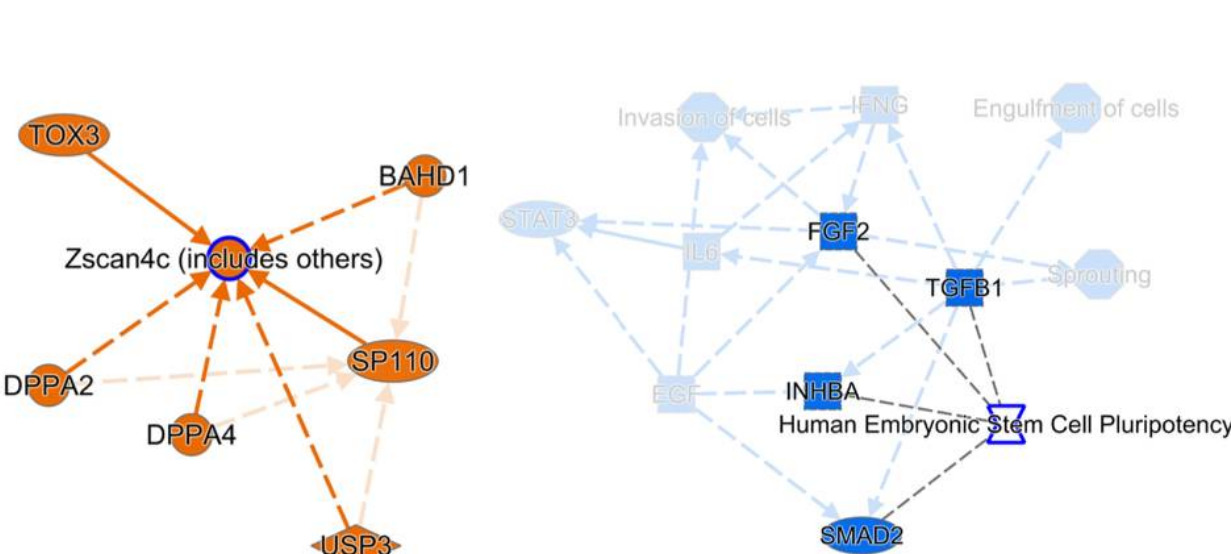
Figure 5. Differential gene and pathway analyses of TBLCs and mid-late 2-cells. ( A ) Heatmaps showing average differential gene expression patterns of mid-late 2-cells (top) and TBLCs (bottom) gene markers. Scale bar indicates z-scored gene expression value. ( B ) The top 5 canonical pathways were derived from ingenuity pathway analysis (IPA) gene ontology with gene markers of mid-late 2-cells (top) and TBLCs (bottom). ( C ) Graphical summary of the predicted pathway regulations of gene markers within mid-late 2-cells (left) and TBLCs (right). Orange lines indicate upregulation while blue colors indicate downregulation.